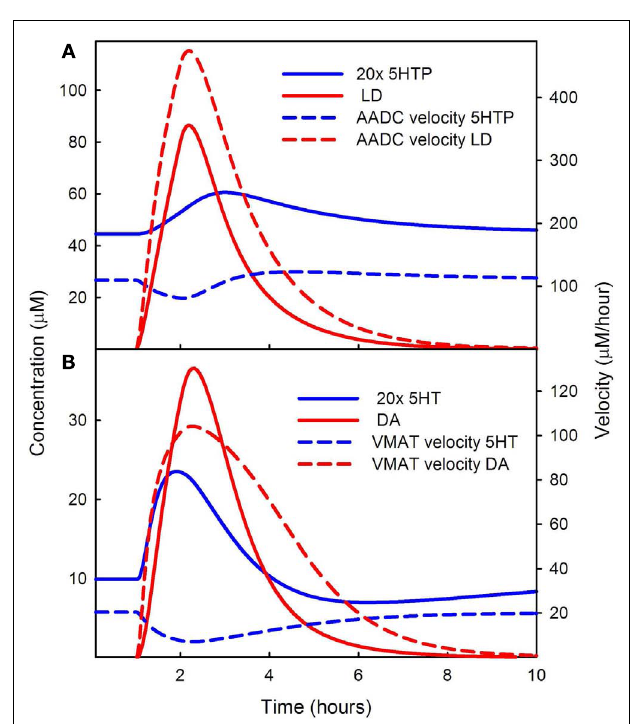
FIGURE 3 | Competition of LD forAADC andVMAT. In (A) the solid blue curve shows the concentration of 5HTP and the dashed blue curve shows the rate at which 5HT is being produced during the LD dose.The solid red curve shows the concentration of LD in the cytosol and the dashed red curve shows the rate of formation of DA in the 5HT neuron. Note that the solid blue curve blue has been multiplied by an extra factor of 20. LD outcompetes 5HTP for AADC because its concentration in the cytosol is much higher than the concentration of 5HTP. (B) Shows 20 times the cytosolic concentration of 5HT (solid blue curve) and the cytosolic concentration of DA (solid red curve).The rate of putting DA into vesicles (dashed red curve) is much higher than the rate of putting 5HT into vesicles. See Discussion in the